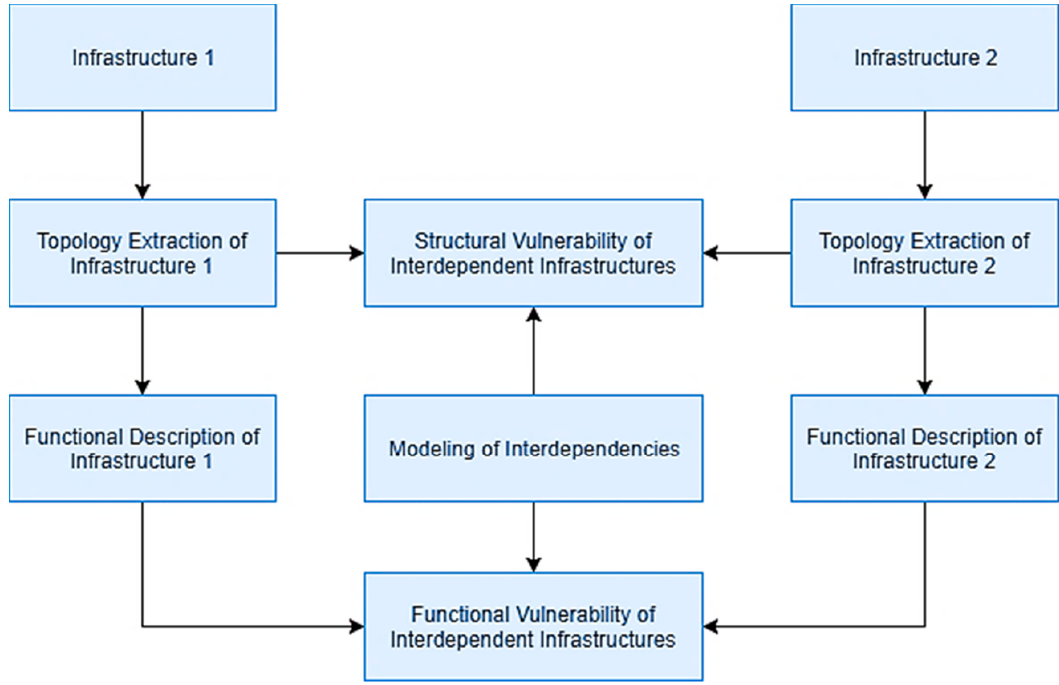
Figure 2. A methodological approach to analyze interdependent infrastructure vulnerabilities (adapted from Ouyang et al. [9]).